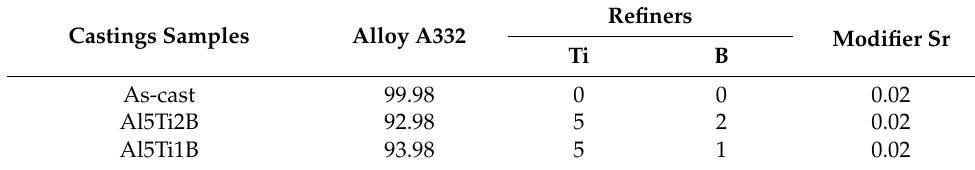
Table 2. Alloy compositions prepared as a function of grain refiner